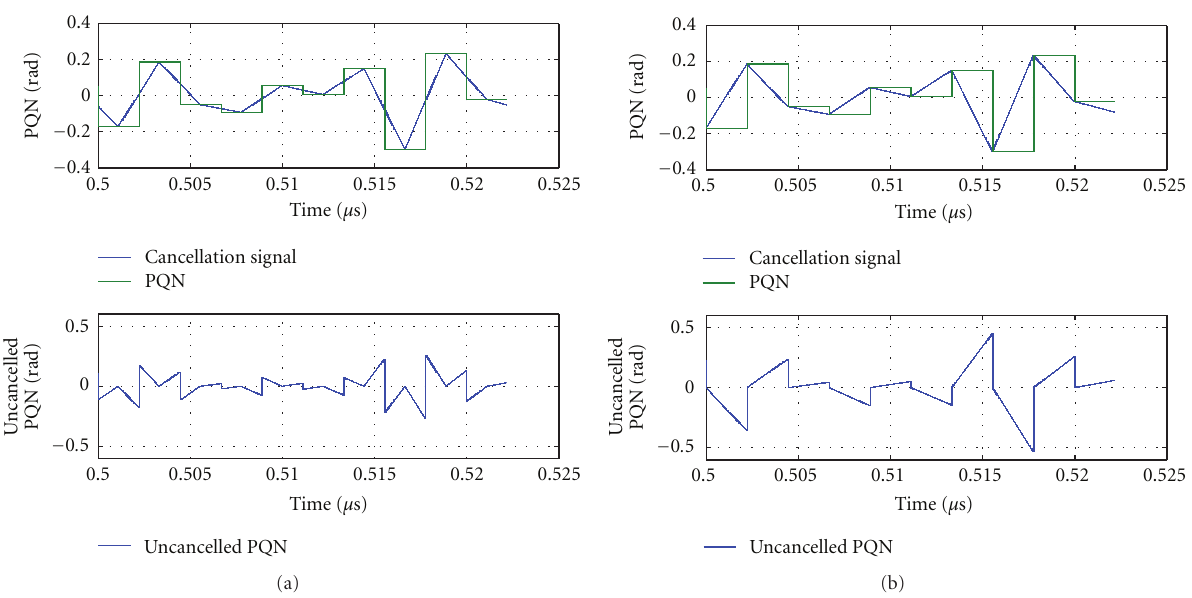
Figure 8: Timing diagram for PQN cancellation technique for (a) T s / 2 advancement in cancellation signal and (b) no advancement in cancellation